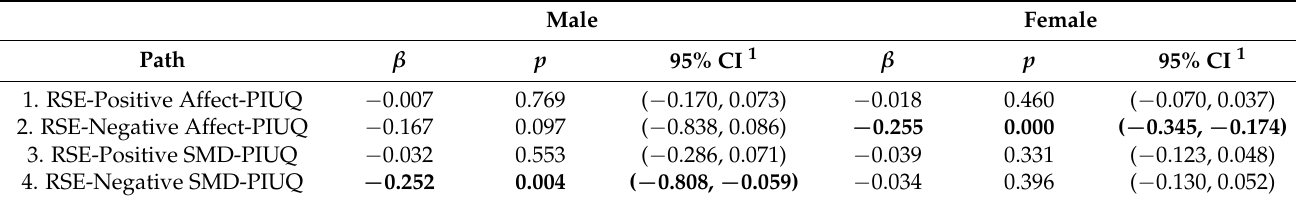
Table 9. Standardised results of mediation effects (split by gender). Male